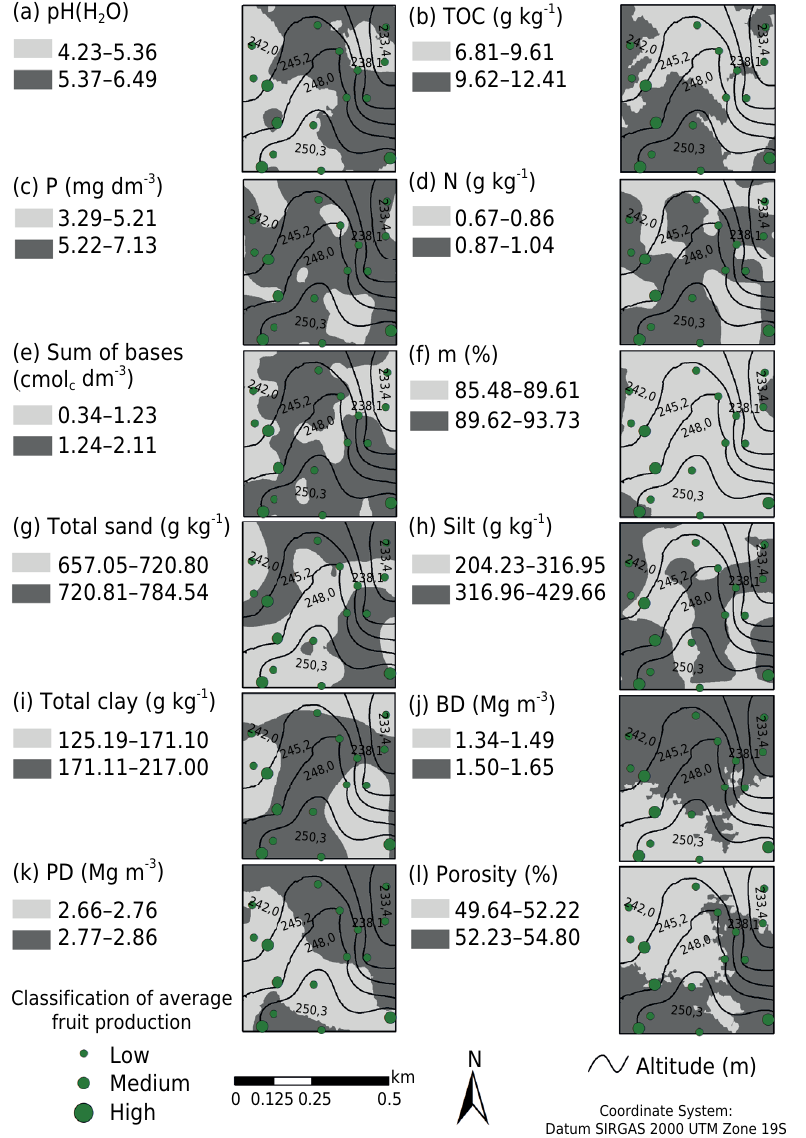
Figure 7. Spatial distribution of soil physical and chemical properties in Filipinas – Plot 2, in the state of Acre, Brazil. Lines and values in the maps correspond to the altitude of the area, circles correspond to the average fruit production between the years 2010 and 2020, and values presented in the legends are the soil